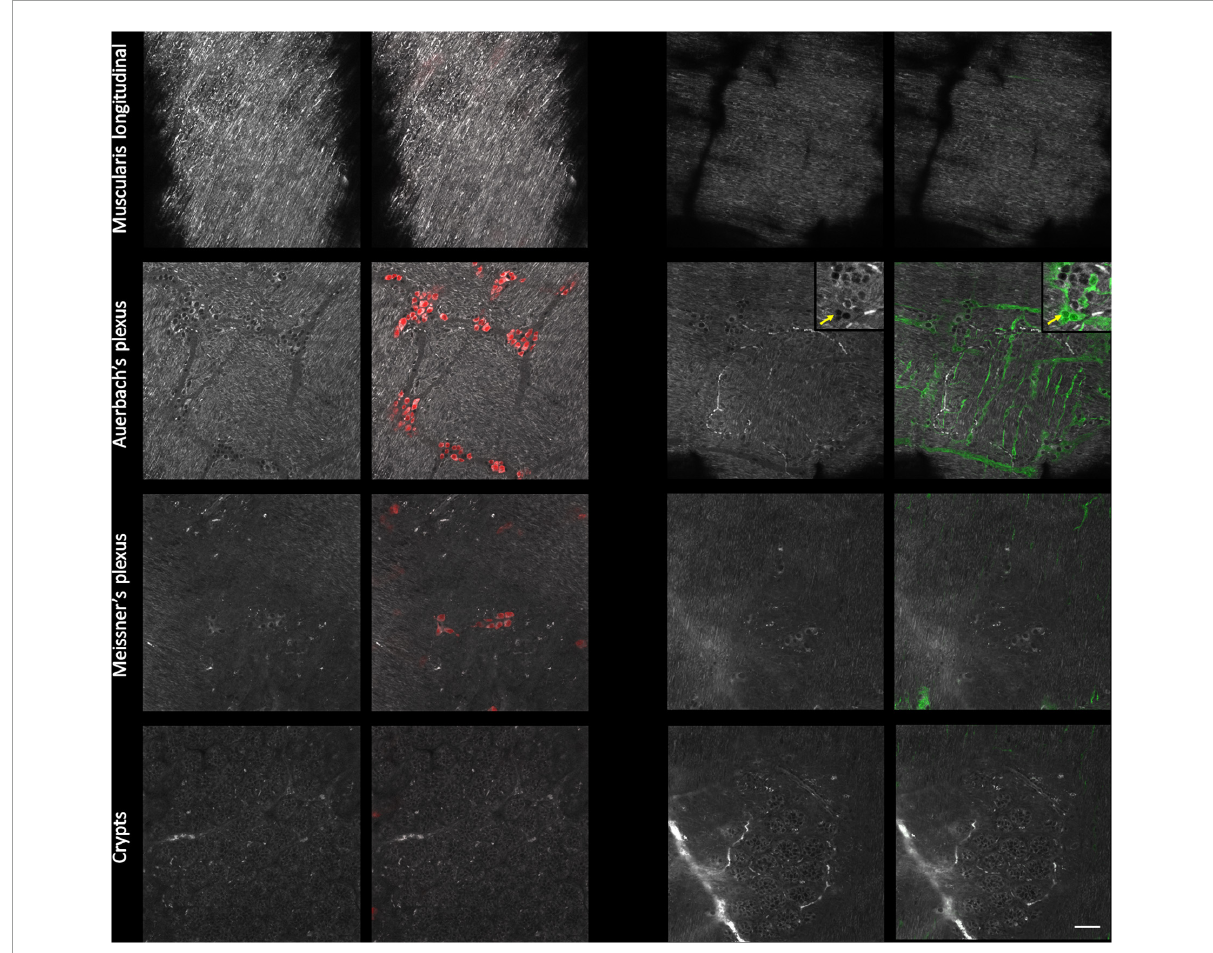
FIGURE3 Immunohistological characterization of the autofluorescent structures of the enteric nervous system (ENS). Single autofluorescent images (grayscale) taken at different depth in the intestinal wall ( muscularis longitudinalis , Auerbach’s plexus , Meissner’s plexus , and crypts) and corresponding immunolabeled images. Red: neurons cell bodies (Hu C/D); green: enteric glia (S100 β ); inset : crop showing enteric glia and AF colocalization with S100 β immunolabeling; yellow arrow: enteric glia cell bodies. Scale-bar: 50 µ